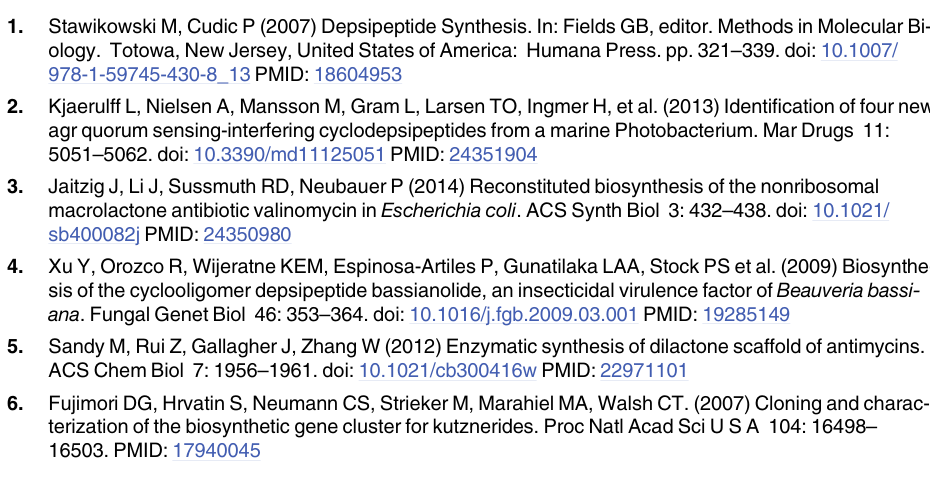
S1 Table. SmartFormula analysis of mass spectra of putative cereulide precursors. Analysis was performed on the mass spectra shown in Fig 8. S2 Table. MS analysis of a reaction of in vitro-reconstituted cereulide synthetase. Analysis was performed on the mass spectra shown in S4